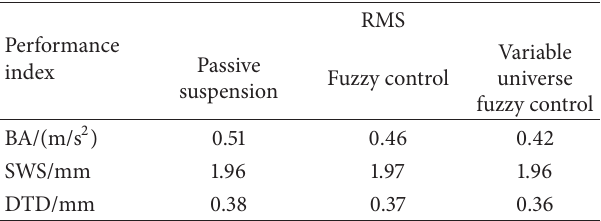
Table 3: Suspension performance of B-class random road.